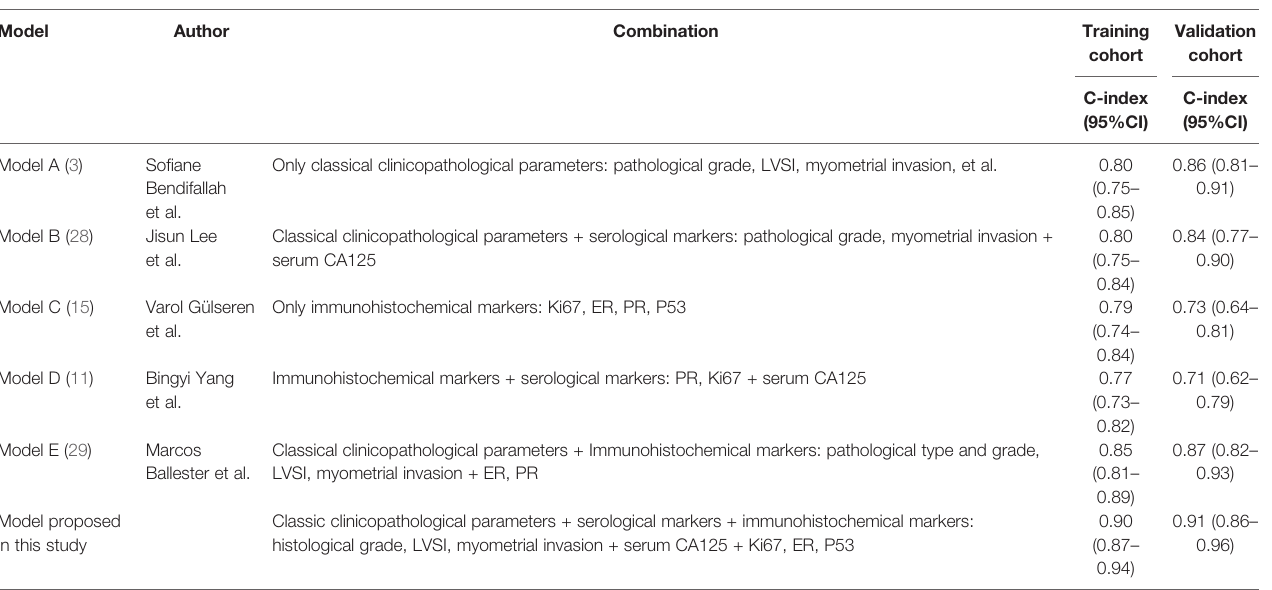
TABLE 3 | The discriminatory power (C-index) of different models in the training and validation cohorts.